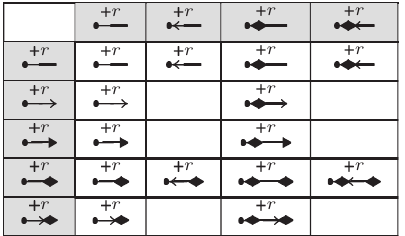
Table 3. Permissible combinations of role designations entailing